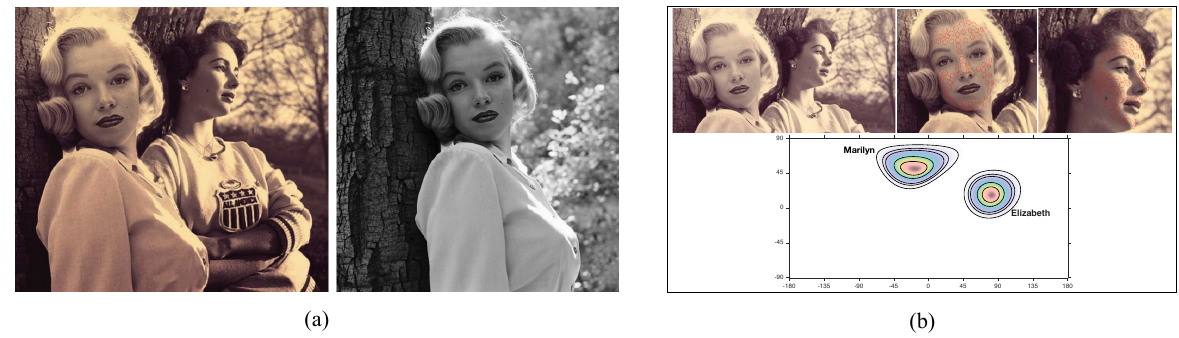
Figure 2 - ( a ) Example of image splicing, which circulated in social media in 2017. The left figure is the result of an image splicing while the right one is the host image used to construct the forged one. Source: Gizmodo (Novak 2017a). ( b )Application of the method by Carvalho et al. (2015). Top row: input image, and normal marks for Marilyn Monroe’s and Elizabeth Taylor’s faces. Bottom row: estimated light source regions. The presence of two regions without intersection is an indicative of image splicing/composition.